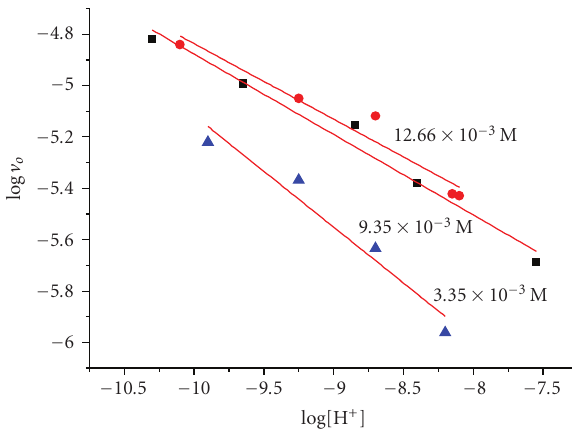
Figure 3: The variation of the logarithm of the initial rate ( v o ) versus logarithm of [H + ] at di ff erent hydrogen peroxide concentrations for the system PAla-Cu(II), [PAla] = 2 . 0 × 10 − 3 M, [Cu 2+ ] = 5 . 0 × 10 − 4 M. T = 298